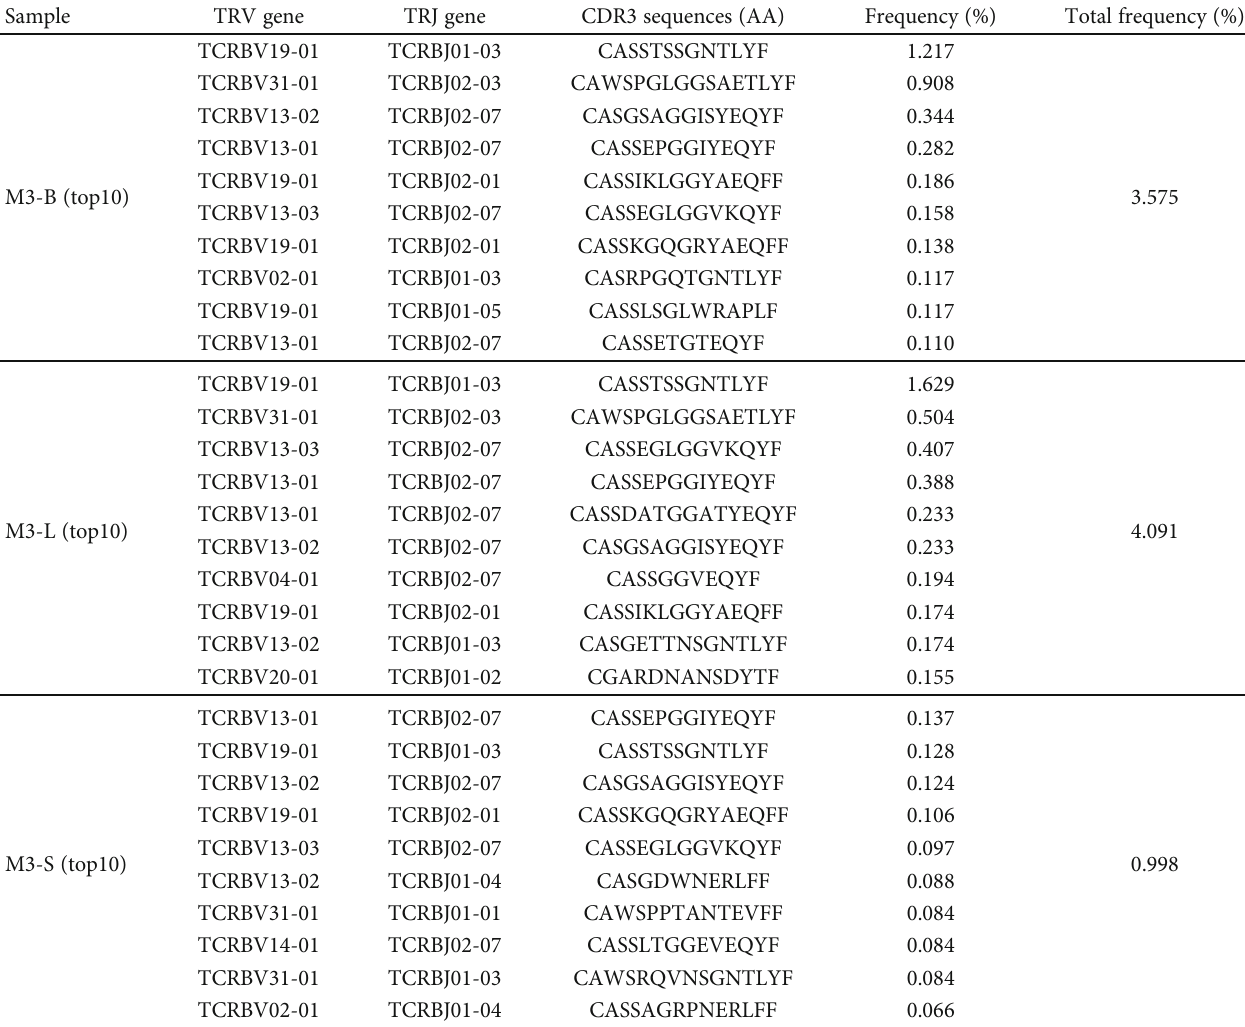
Table 7: Analysis of composition and characteristics of frequency for the top ten sequences and the usage of TBBV and TRBJ gene, CDR3 AA of CD4 + CD25 + T cells TCR β CDR3 repertoires in breast tumor tissues, lung metastatic tissues, and spleens from 4T1 tumor-bearing BALB/c mouse